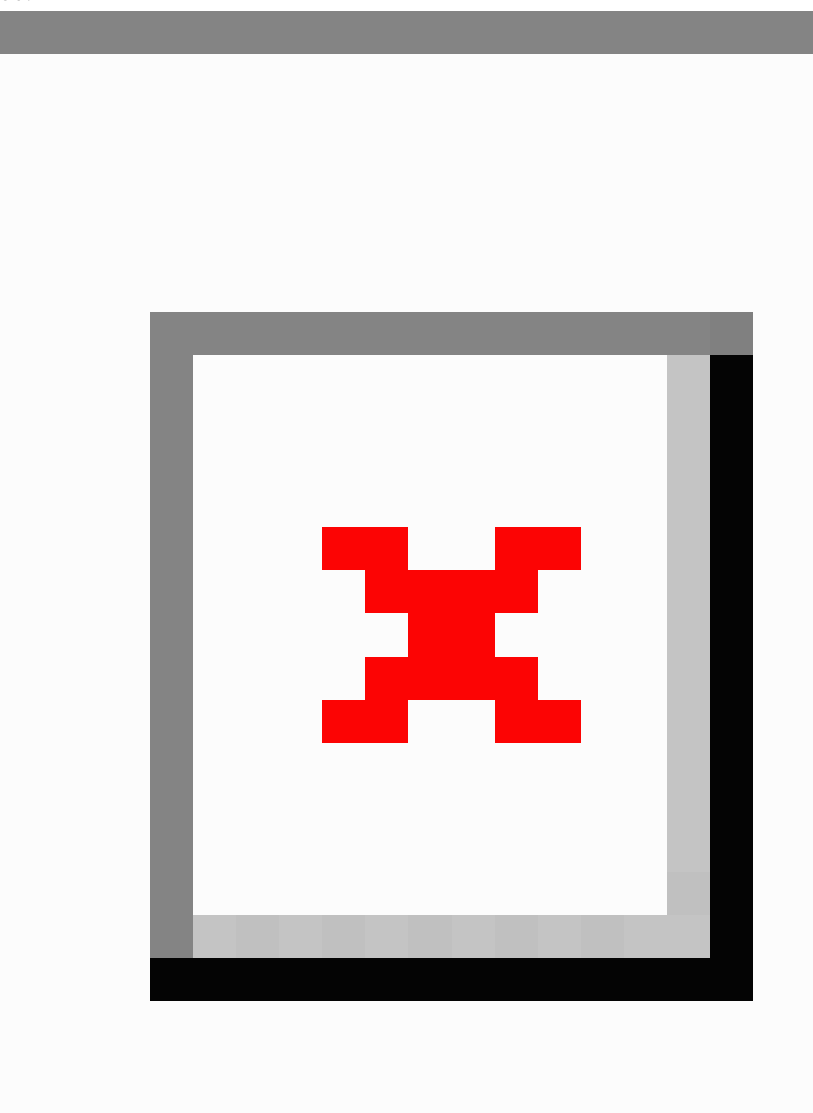
Figure 1. Flow of participants through the study. PPI = proton pump inhibitor. GERD = gastroesophageal reflux disease. QOLRAD = Quality of Life in Reflux and